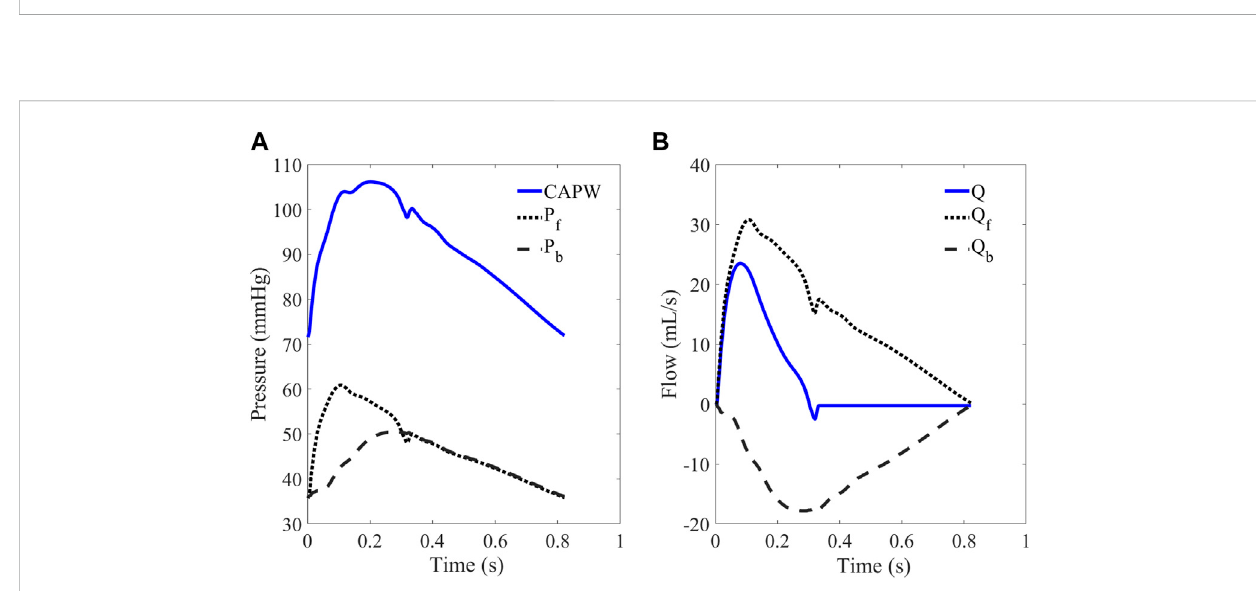
FIGURE 4 (A) CAPW and (B) fl ow waveform. The CAPW is decomposed into P f and P b , from which RM and RI can be